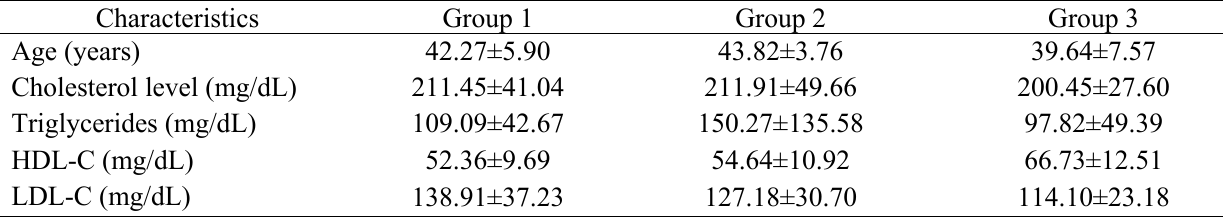
Table 1. Baseline characteristics of the subjects